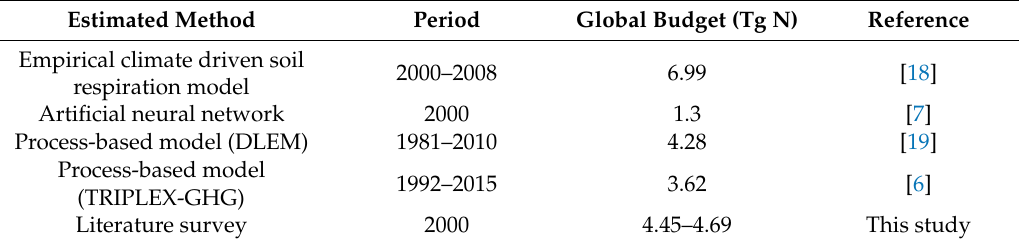
Table 1. Comparison of total forest N 2 O budget with previous